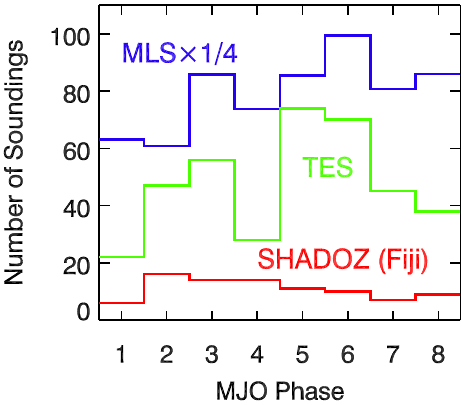
Fig.9. ThenumberofMLS(blue)andTES(green)swathfootprintsthatfallintothe10 ◦ -longitude × 8 ◦ -latitude box centered at Fiji used in this study. The count of MLS has been scaled down by a factor of 4. The number of SHADOZ ozonesonde measurements used in this study is shown in red.